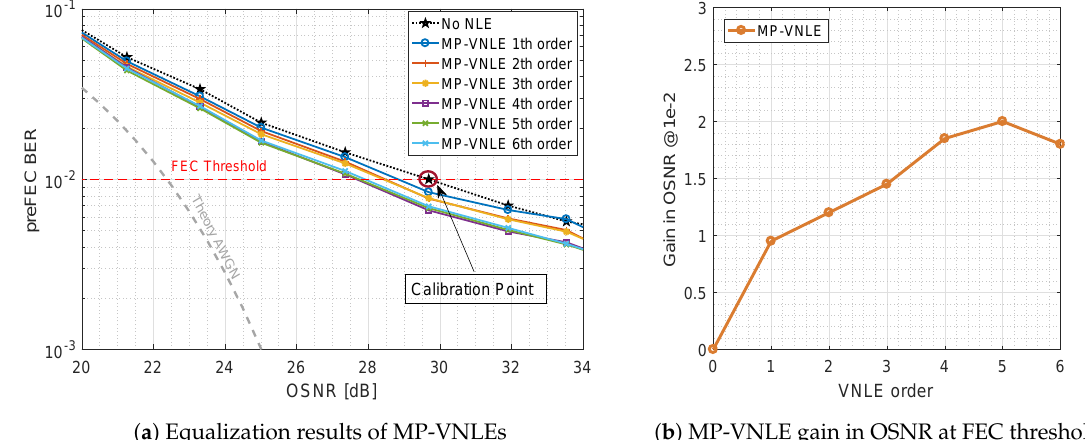
Figure 8. optical back-to-back 600 Gb/s/ λ MP-VNLE preFEC measurement